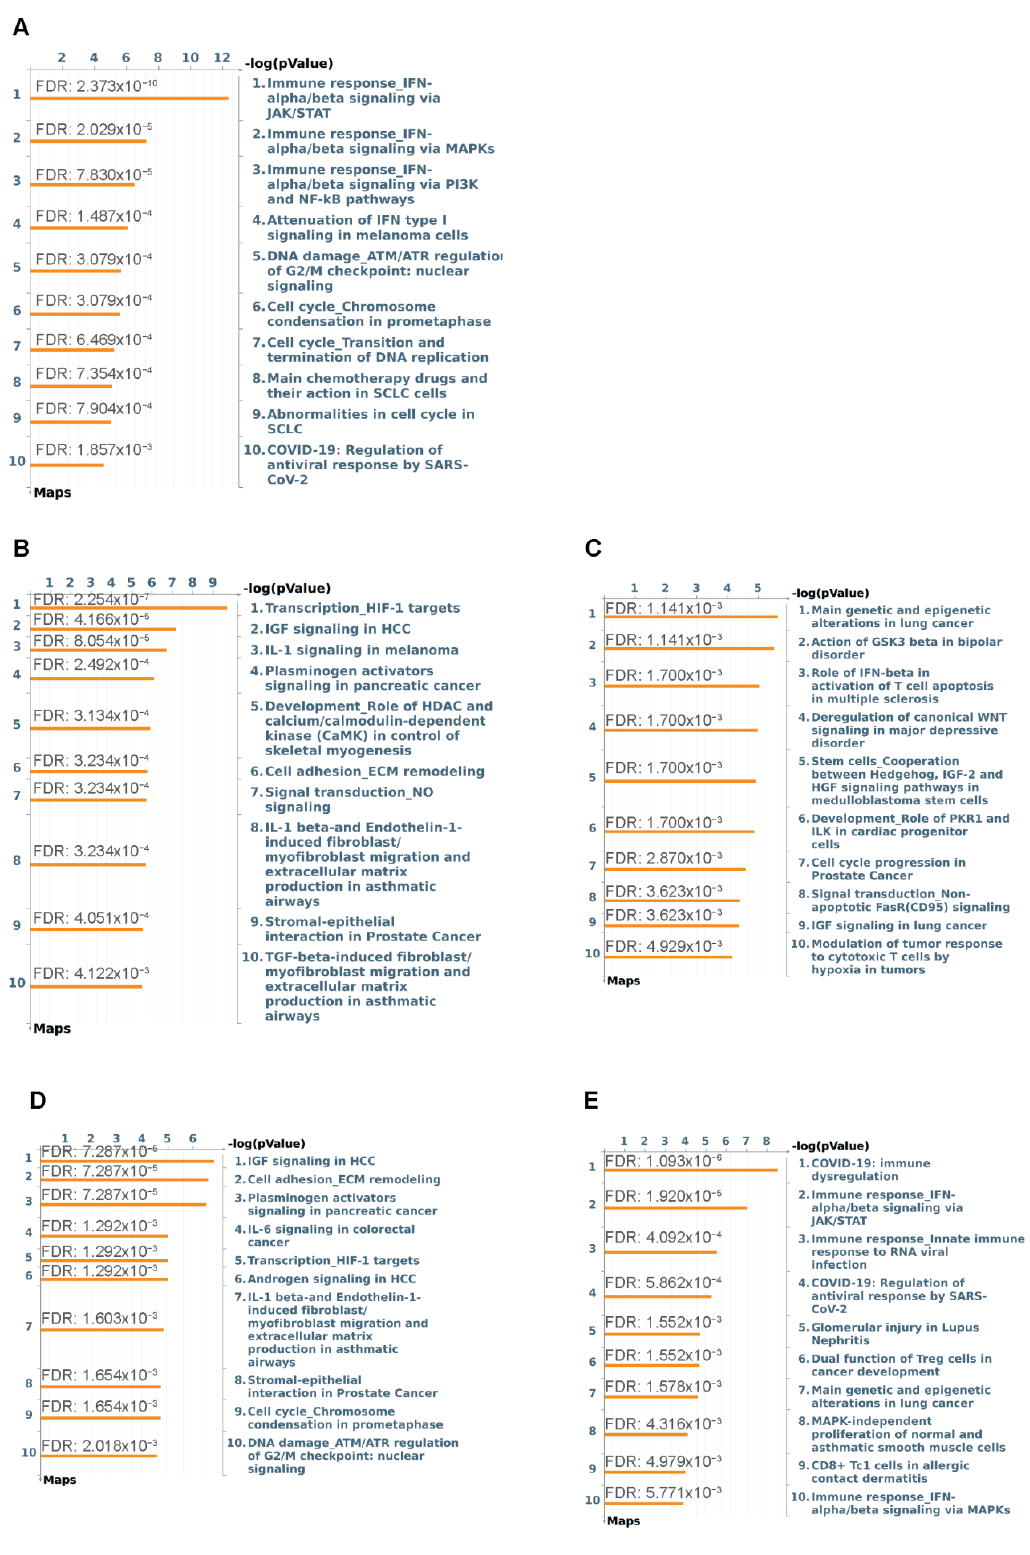
Figure 3. Metacore pathway enrichment analysis of DEGs. ( A ) Top 10 most significantly en- riched pathways map for the upregulated DEGs comparing mild/moderate to healthy control (MldMod vs. HC_UP). ( B ) Top 10 most significantly enriched pathways map for the upregulated DEGs comparing severe to healthy control (Svre vs. HC_UP). ( C ) Top 10 most significantly enriched pathways map for the downregulated DEGs comparing severe vs. healthy control (Svre vs.